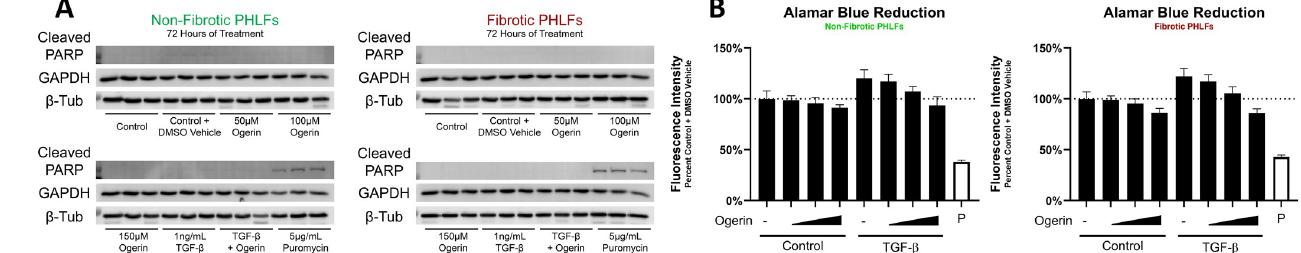
Fig 4. Prolonged treatment of Ogerin in the presence or absence of TGF- β does not induce apoptosis or negatively impact cellular viability. A: Primary human lung fibroblasts derived from non-fibrotic or IPF patients were treated +/- DMSO Vehicle, +/- 1ng/mL TGF- β , +/- 50–150 μ M Ogerin, or 5 μ g/mL Puromycin (P) for 72 hours. Whole cell lysates were analyzed for cleaved PARP expression level via Western Blot with GAPDH and β -Tubulin as loading controls, n = 3 per donor per treatment group. B: Primary human lung fibroblasts derived from non-fibrotic or IPF patients were treated with the following reagents: +/- DMSO Vehicle, +/- 1ng/mL TGF- β , +/- 50–150 μ M Ogerin, or 5 μ g/mL Puromycin for 72 hours. Following this incubation period, Alamar Blue cell viability reagent was added and allowed to incubate for 4 hours. Fluorescence intensity (Excitation 535nm, Emission 595nm) measured and expressed as a percent of DMSO Vehicle control. n = 8 per donor per treatment group, bars representative of technical replicate average +/- SEM. Representative images of cells following 72-hour treatment available in S6 Fig.